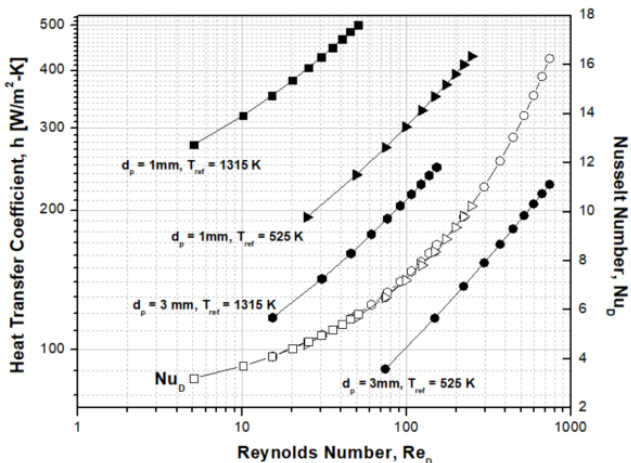
Figure 4. The Nusselt number and heat transfer coefficient with the particle diameter and temperature.